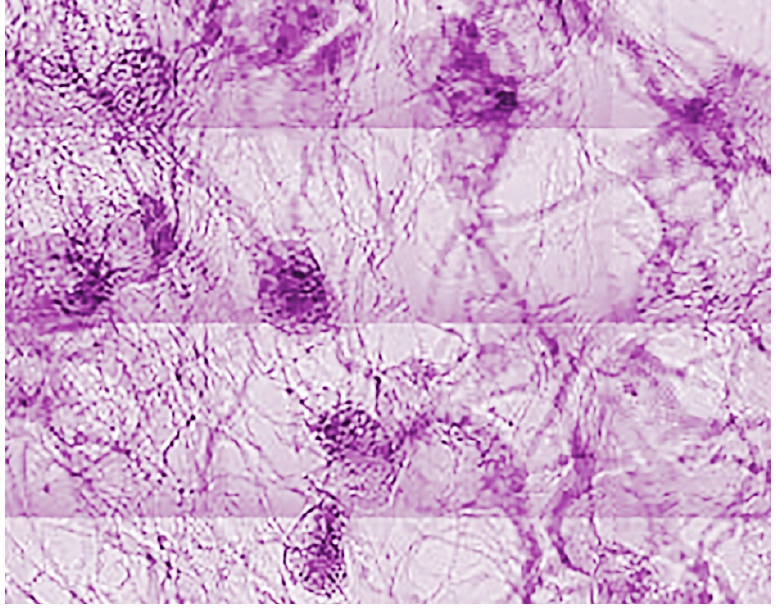
Figure 28. Neuron network specimen, one of the first coherence-based radiography results obtained under the SYNAPSE program [10].